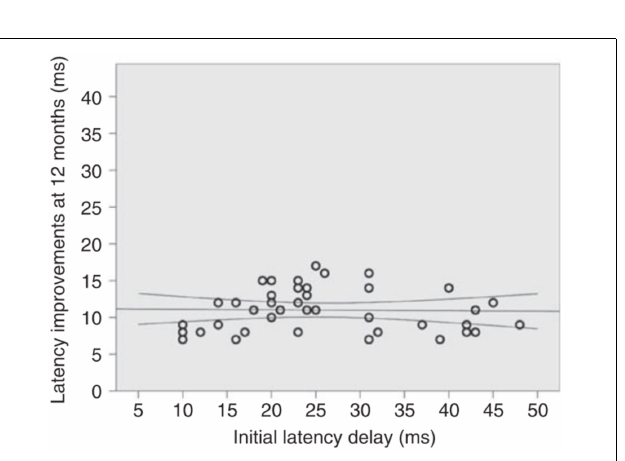
FIGURE 5 | Example of mfVEP latency asymmetry values of individual segments (left) and plot of probability values of deviation from normative database.